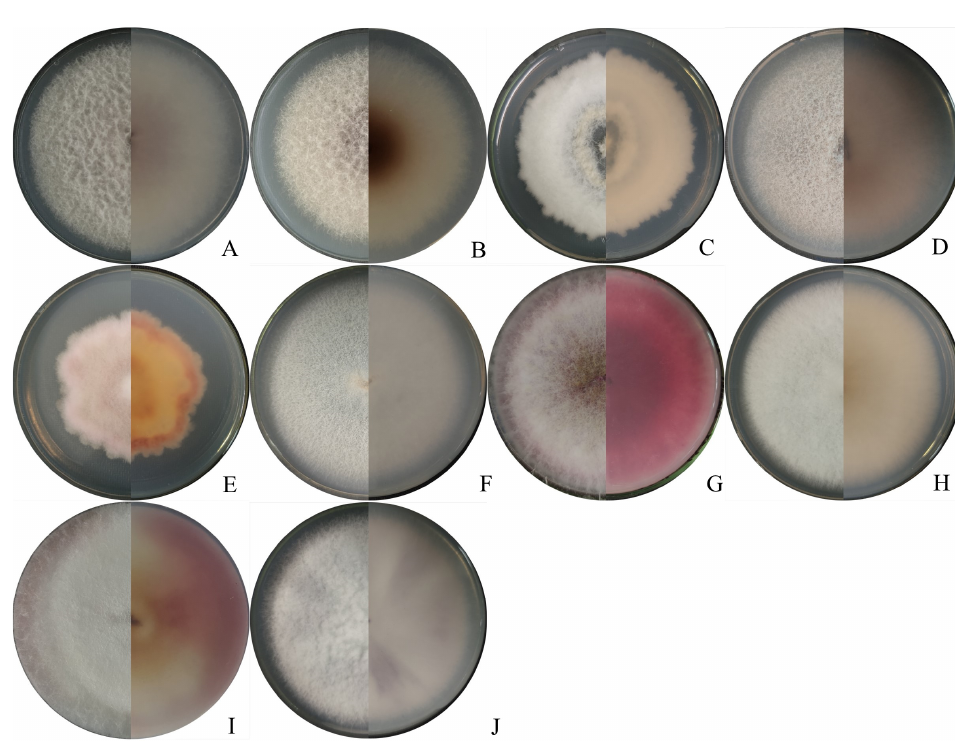
Figure 2. Colony appearance of representative isolates of 10 Fusarium species. ( A – J ) Colonies of the representative isolates of F. verticillioides , F. subglutinans , Fusarium incarnatum - equiseti species complex, F. temperatum , F. acuminatum , F. solani , F. sporotrichioides , F. tricinctum , F. asiaticum , and F. proliferatum , respectively.